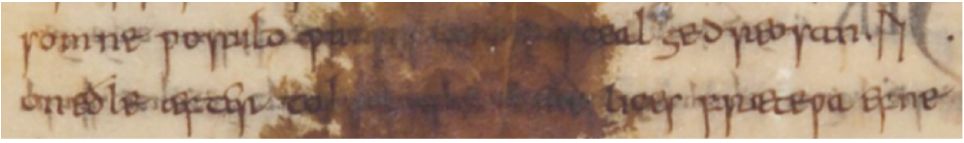
Figure 1. Detail from the signature passage in The Fates of the Apostles . “ ᚢ ・ ” concludes its line on the right, “ on eðle ” begins the next. Biblioteca Capitolare of Vercelli, (MS. CXVII, Codex Vercellensis, f. 54 r ) Copyright: Fondazione Museo del Tesoro del Duomo e Archivio Capitolare di Vercelli. Permission for reproduction granted by Silvia Faccin—Curator of manuscripts and rare books of Biblioteca